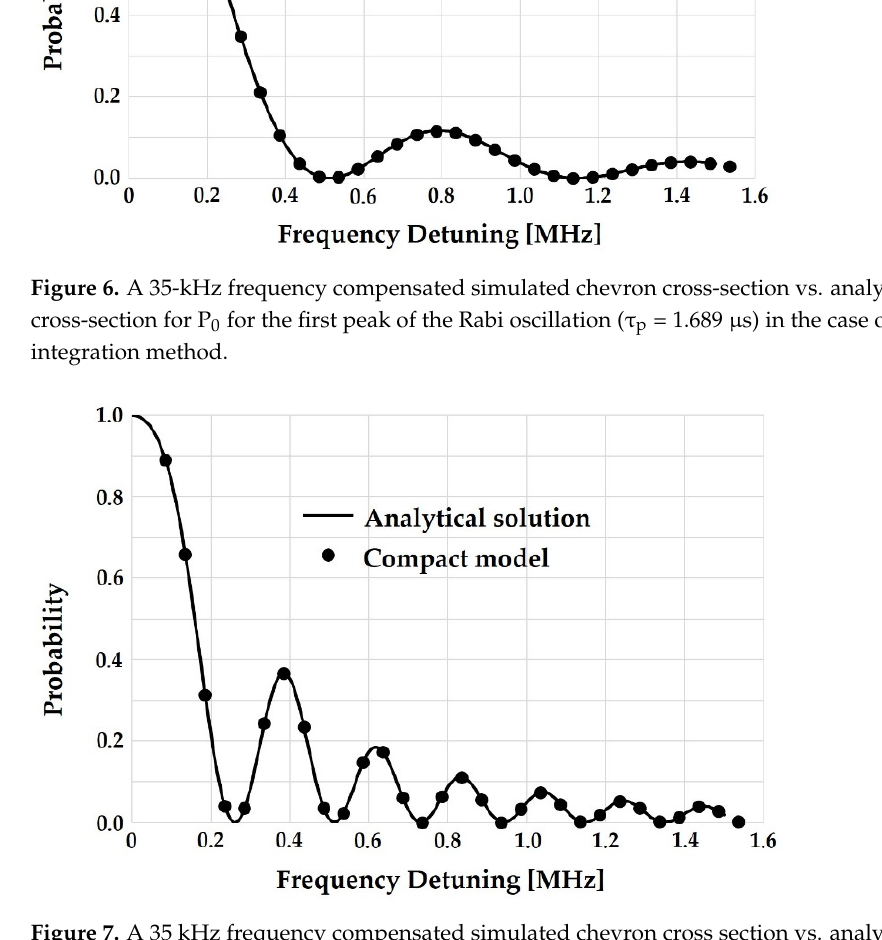
Figure 7. A 35 kHz frequency compensated simulated chevron cross section vs. analytical chevron cross-section for P 0 for the second peak of the Rabi oscillation ( τ p = 5.067 µ s) in the case of trapezoidal integration method.